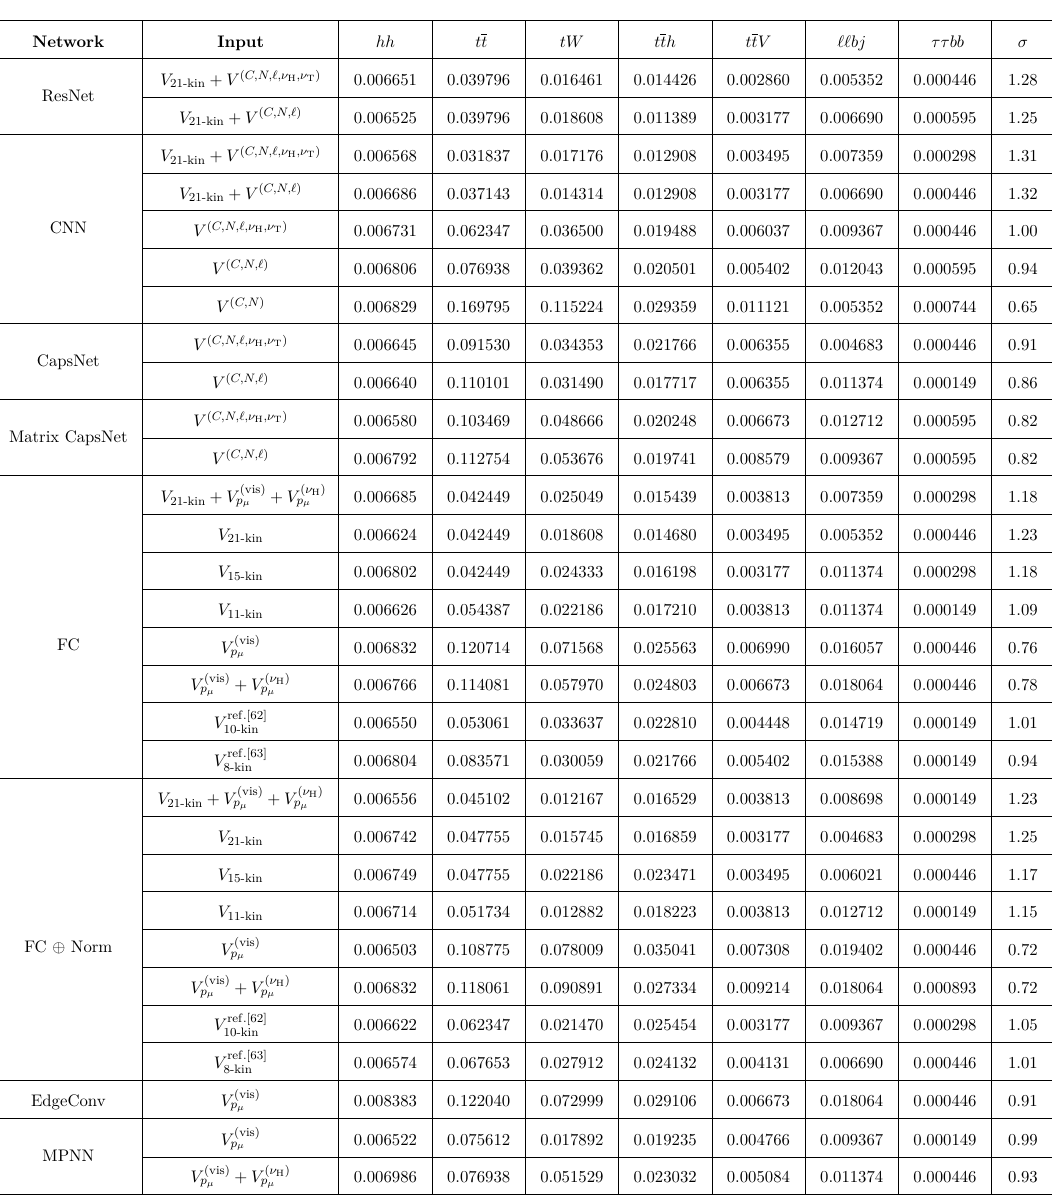
Table 2 . Signal and background cross section (in fb) cutting on NN score for various combinations of NN architectures and inputs. The NN score is chosen such that the signal number of events is approximately 20 ( N 20 .). The significance σ is calculated using the log-likelihood ratio for S ≈ a luminosity of 3 ab − 1 at the 14 TeV LHC. Note that the efficiency of the NN score cut can be calculated by taking the ratio of cross sections in this table and those in table